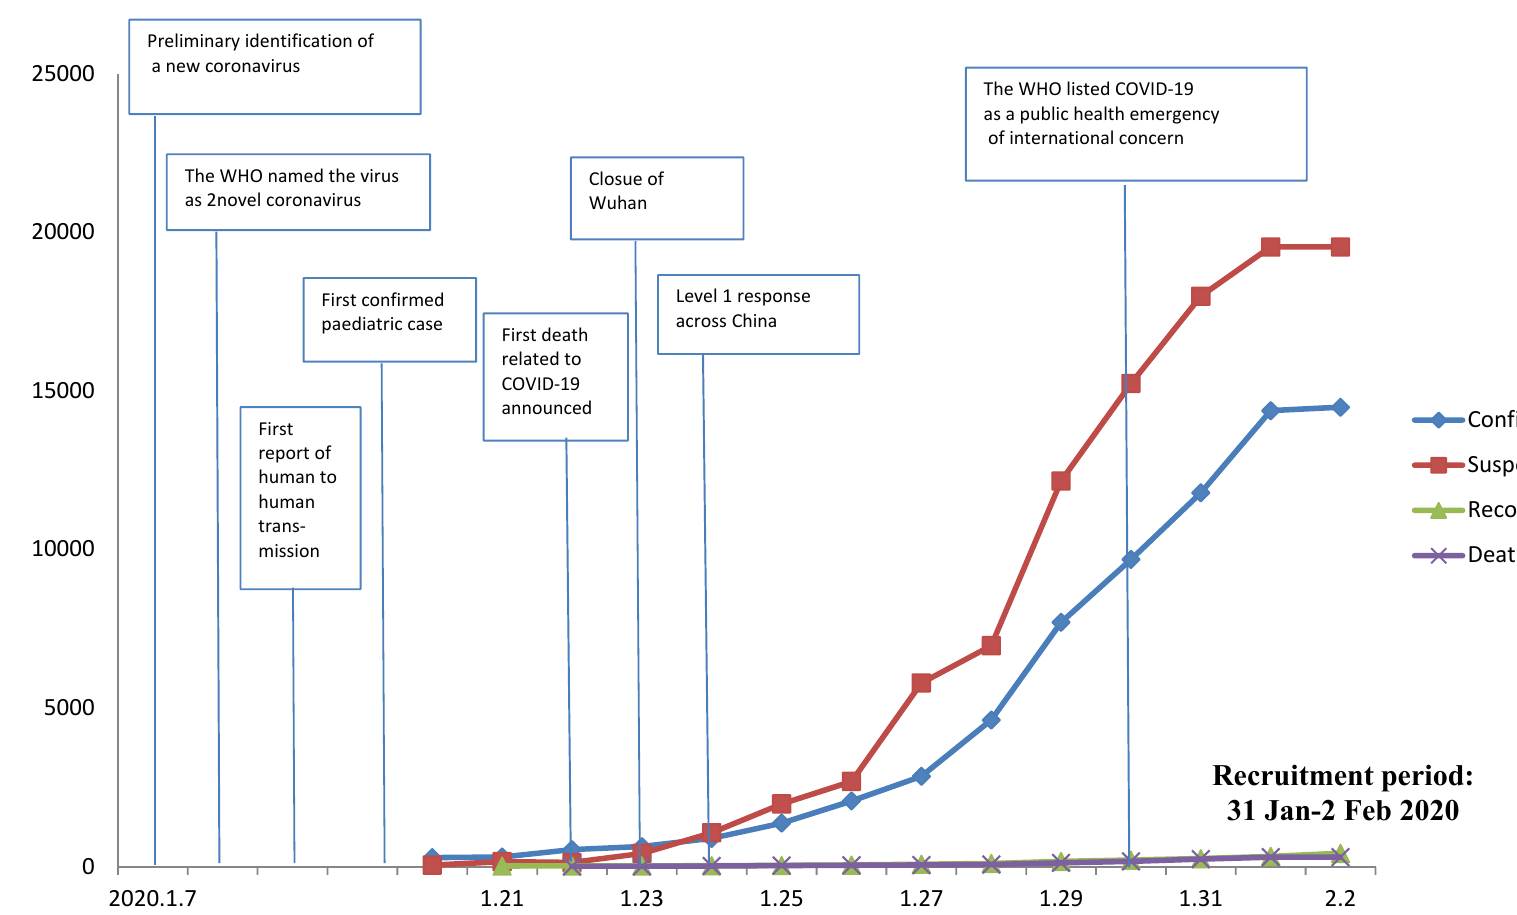
Figure 1. National epidemic trend of the 2019 coronavirus disease (COVID-19) outbreak in China from 7 January to 2 February 2020.